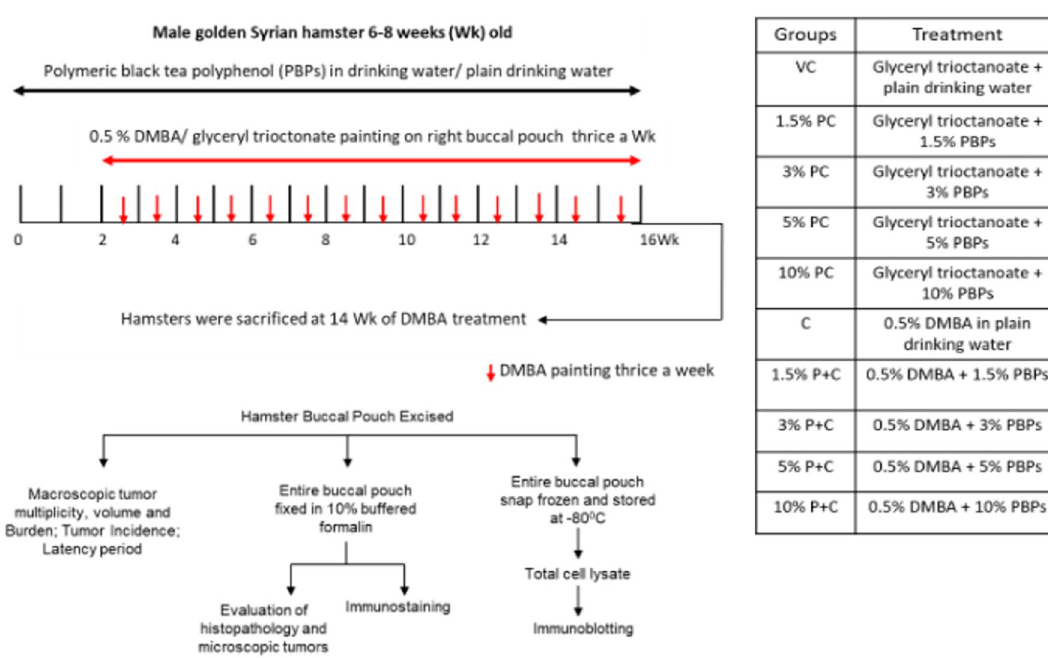
Figure 1. Experimental design for studying the effect of pre and concurrent treatment of different doses of black tea-derived PBPs extract on DMBA induced oral carcinogenesis in the hamster model. 6–8 weeks old male golden Syrian hamsters were randomised into ten groups as vehicle control (VC) PBP control (1.5% PC, 3% PC, 5% PC, 10% PC) carcinogen (C) PBP + carcinogen (1.5% P + C, 3% P + C, 5% P + C, 10% P + C) as shown